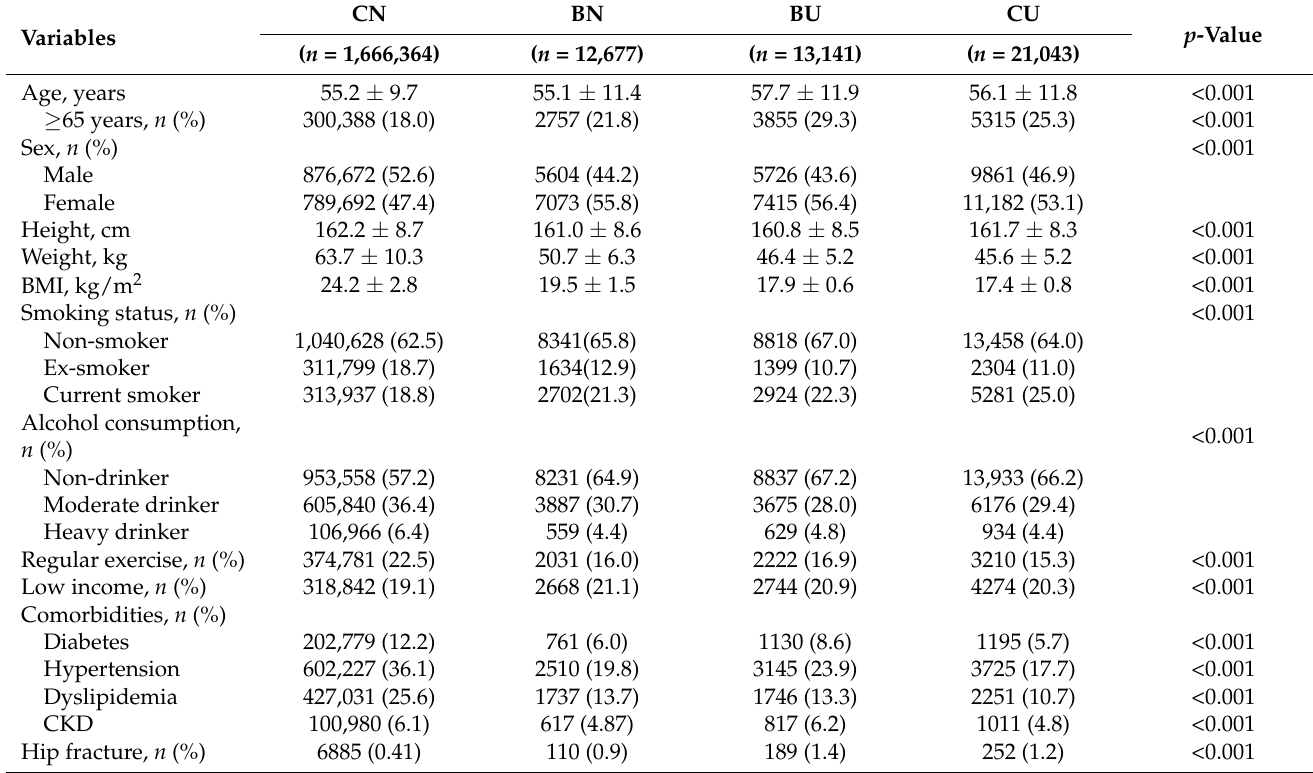
Table 1. Baseline characteristics according to changes in underweight